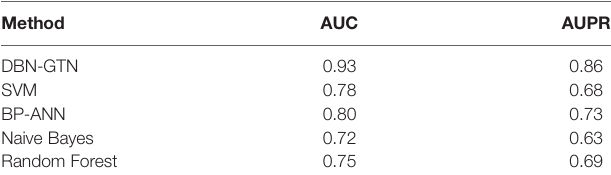
TABLE 1 | AUC and AUPR of traditional methods and DBN-GTN.